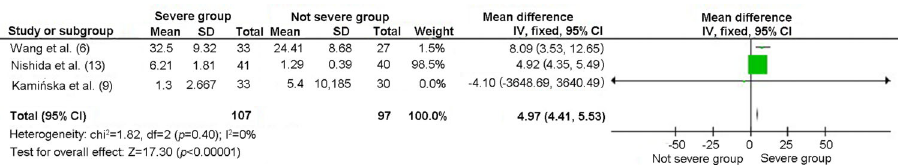
Figure 2 - Forest plot of the relationship between interleukin-6 and the severity of acute coronary syndrome. CI, confidence interval; df, degrees of freedom; SD, standard